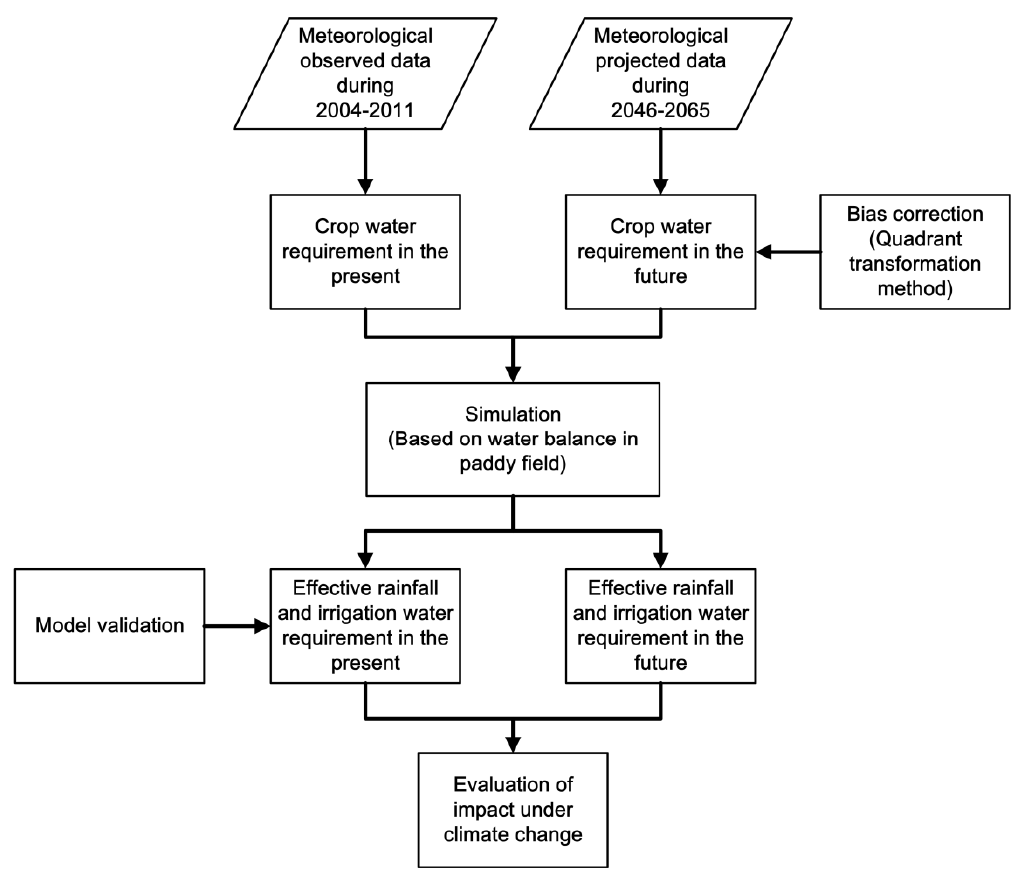
Figure 1. Flow chart of this